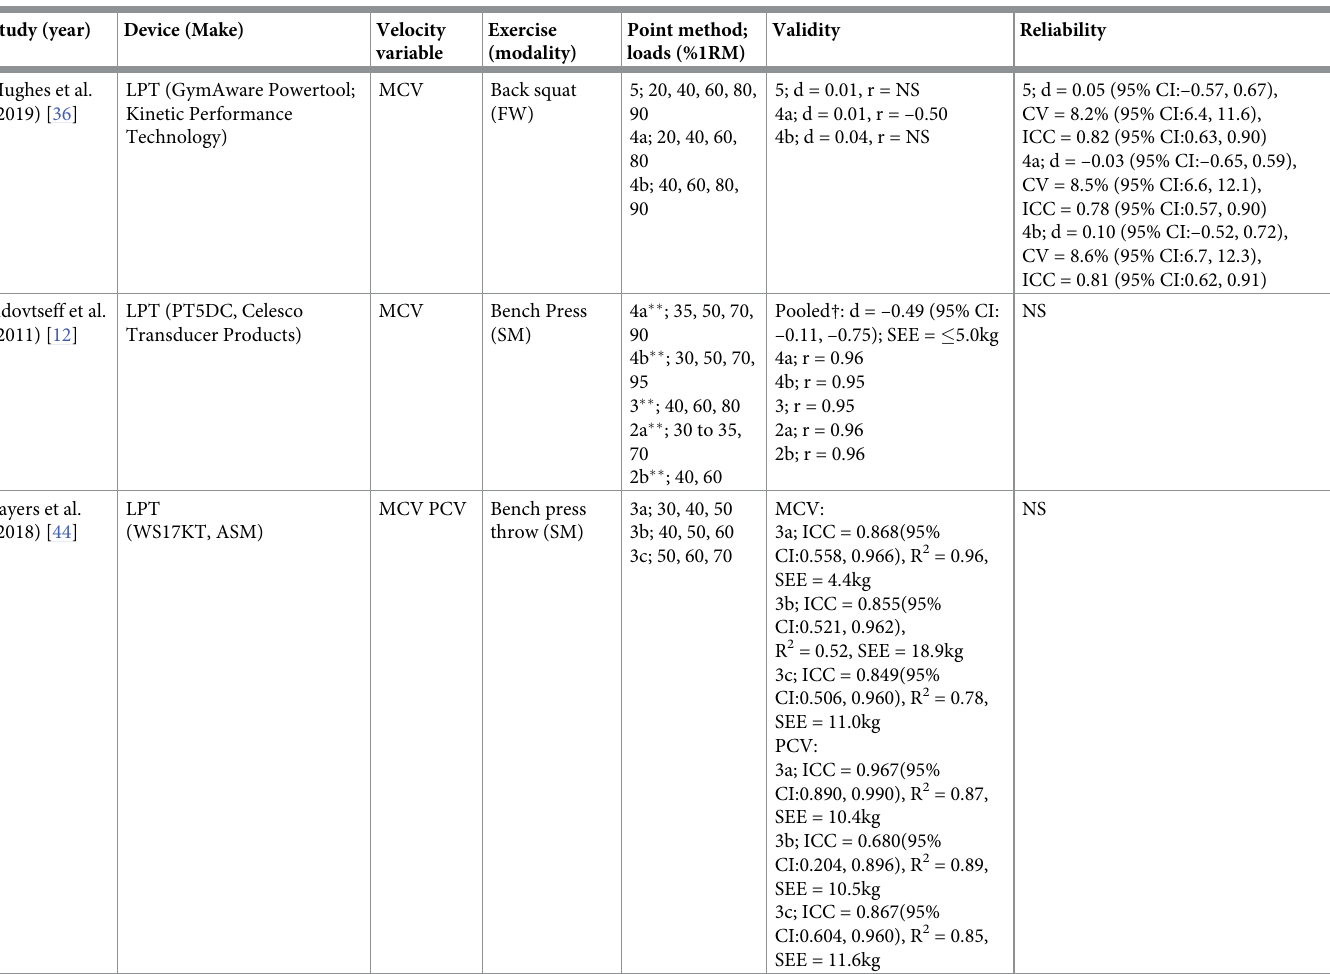
Table 5. Summary of results utilising the load at zero velocity prediction